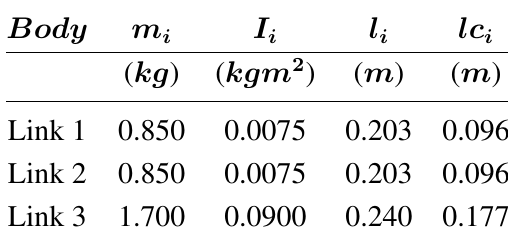
Table 2. UARM Parameters.